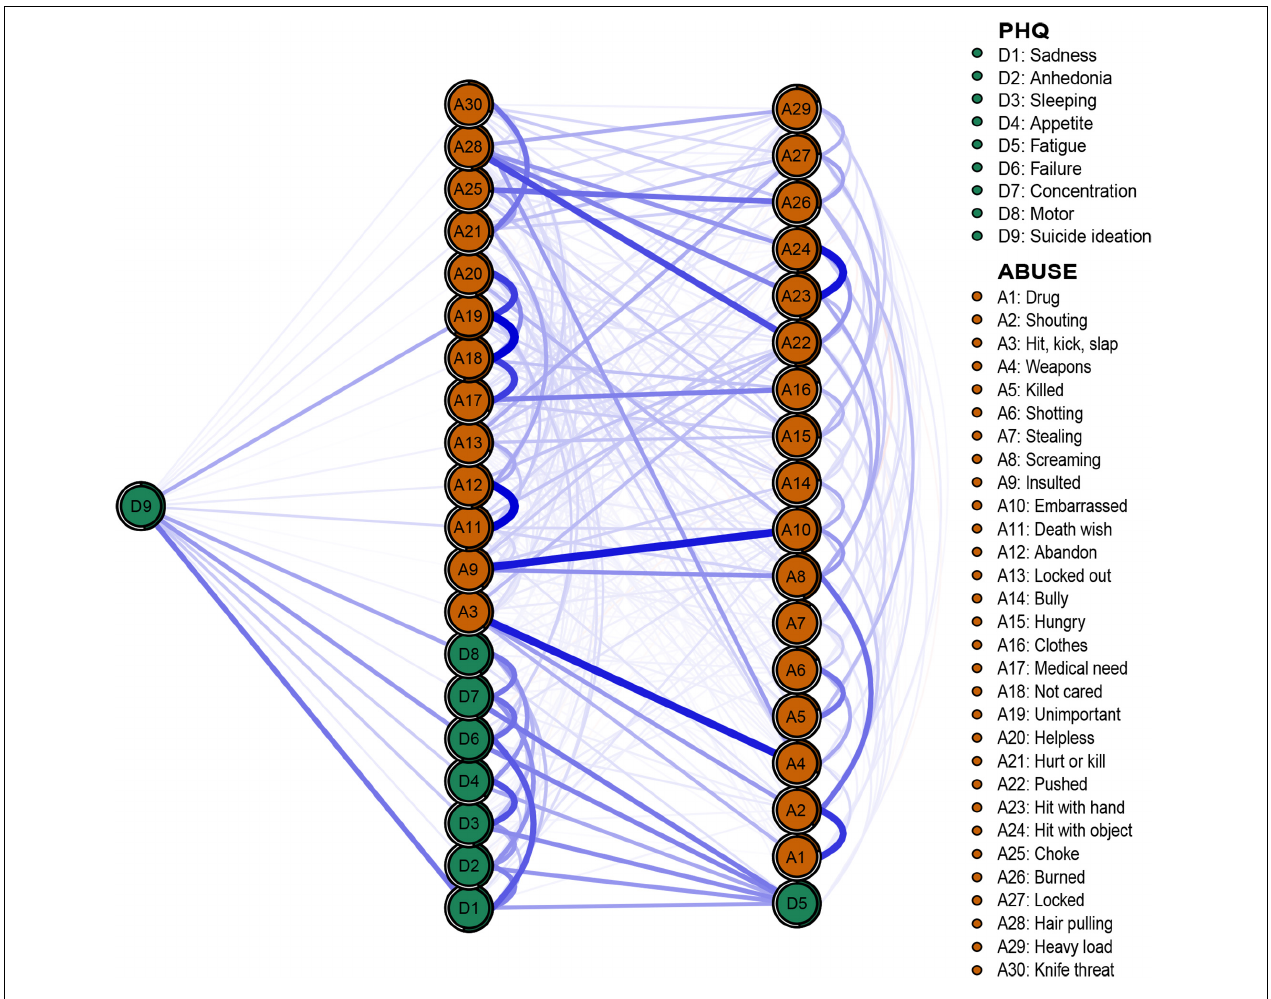
FIGURE 5 | Flow network of suicide